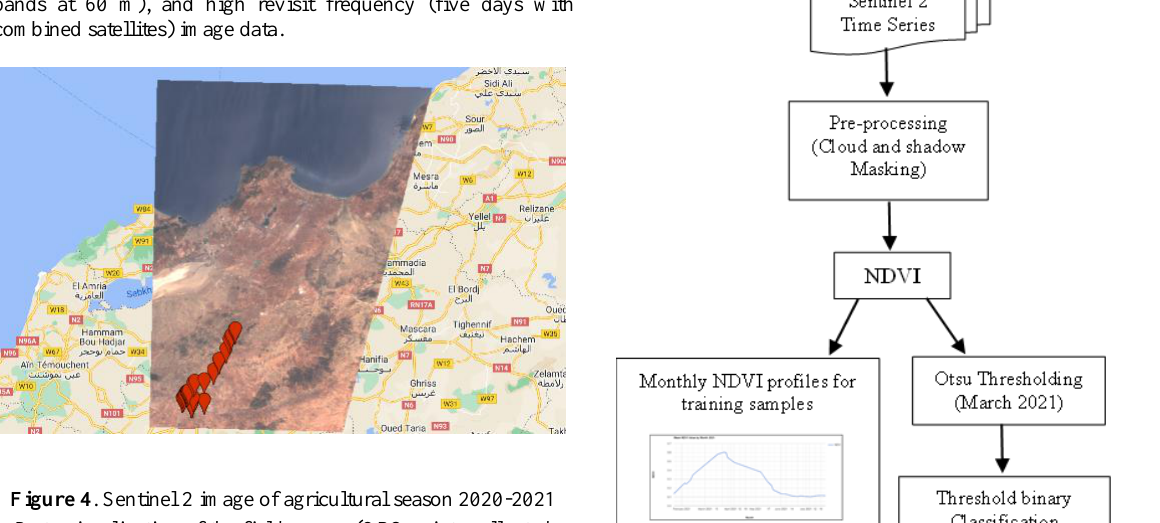
Figure 4 . Sentinel 2 image of agricultural season 2020-2021 Data visualization of the field survey (GPS points collected from the field work in Sidi Bel Abbes 2021 (Red points).